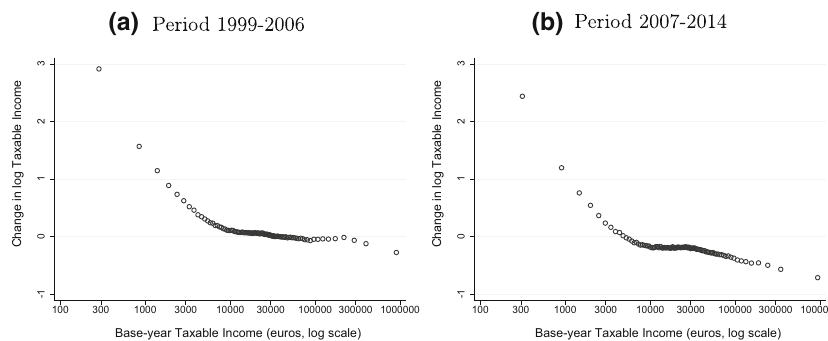
Fig. 3 Mean reversion problem. Notes: Each dot represents the average change in log taxable income for bins of base-year taxable income (in real euros, using a log scale). Observations are grouped into 100 intervals of the horizontal axis with a similar number of observations. Thus, more spaced points indicate that there are fewer taxpayers in a given income range. a Refers to the 1999–2006 period and b refers to the 2007–2014 period. Both figures show the existence of mean reversion in the low and the top tails of the income distribution. Mean reversion is particularly relevant for the second period of analysis ( b ), especially at the bottom of the distribution but also at the